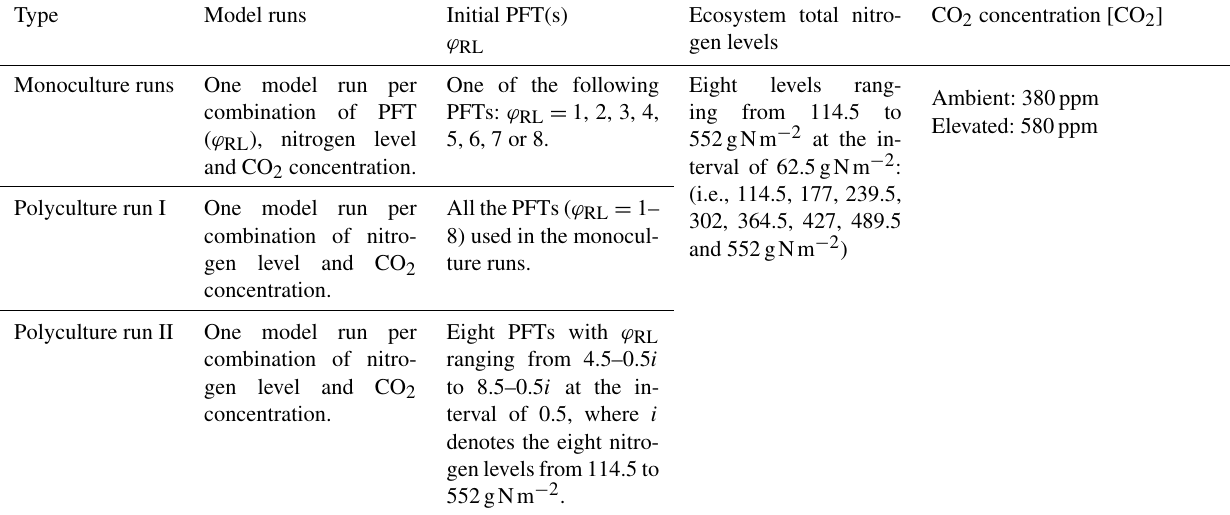
Table 2. Simulation